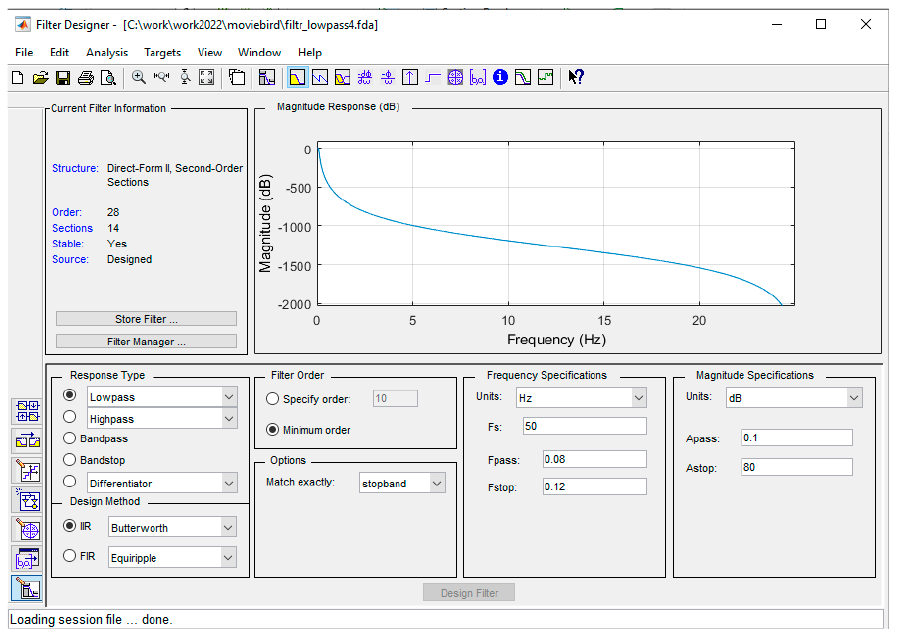
Figure 5. Design of the IIR filter used.